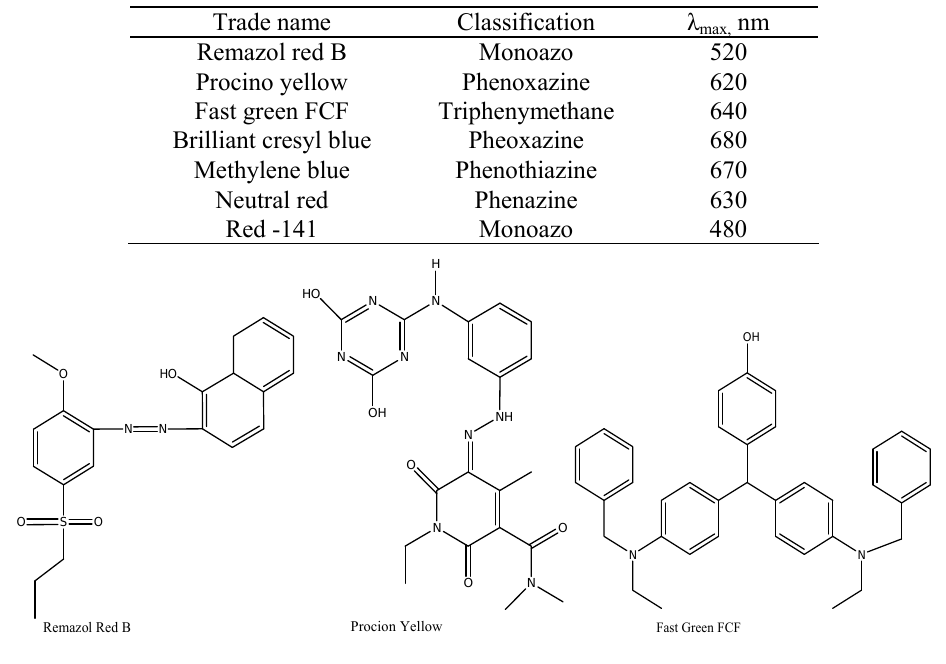
Table 1. The general data of seven dyes used in this